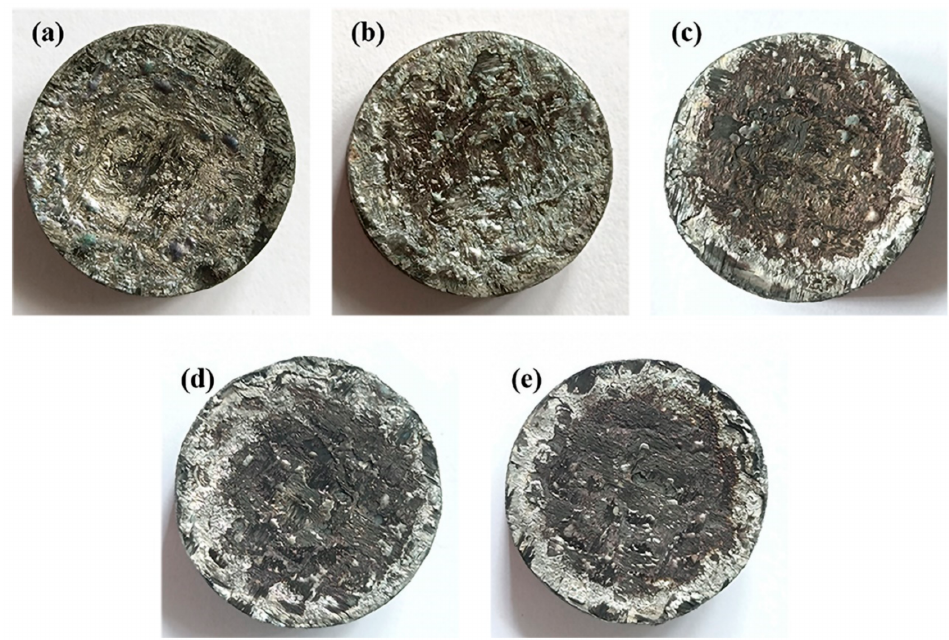
Figure 11. Macroscopic morphology of composites after oxygen–acetylene ablation: ( a ) BP-0, ( b ) BP-5, ( c ) BP-10, ( d ) BP-15, and ( e )